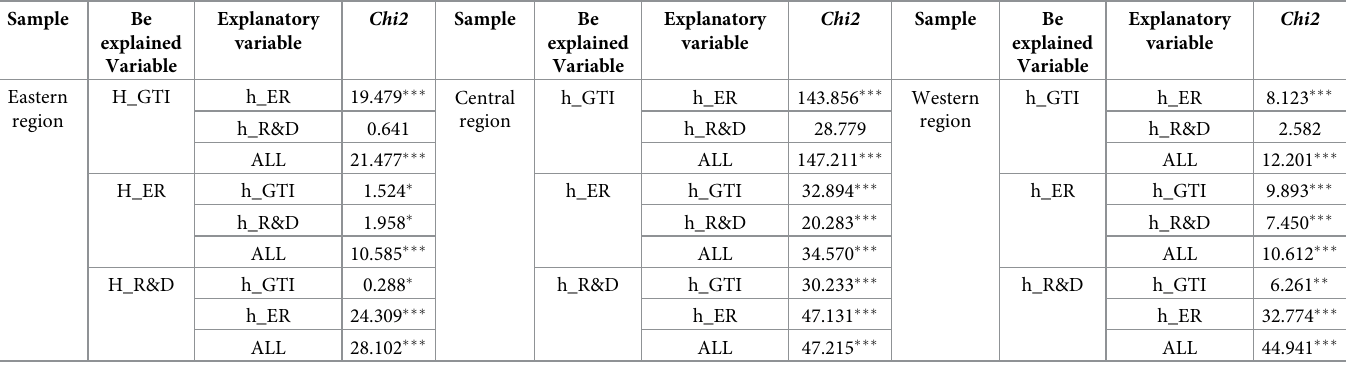
Table 4. Granger causality test